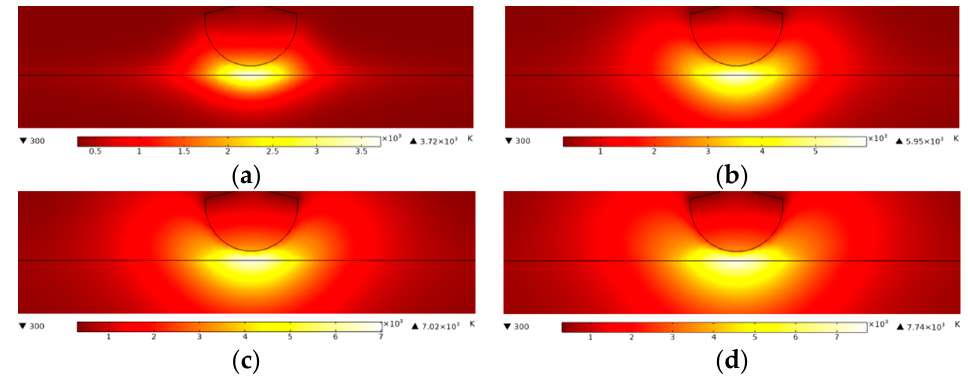
Figure 7. Temperature distribution cloud diagram of the pantograph–catenary arc (when gap is 3 mm). ( a ) 0.1 s cloud chart of arc temperature distribution; ( b ) 0.4 s cloud chart of arc temperature distribution; ( c ) 0.7 s cloud chart of arc temperature distribution; ( d ) 1 s cloud chart of arc temperature distribution. When the gap of the pantograph–catenary is 3 mm, two-dimensional trans sects are defined in the simulation software, which is defined as the upper half-axis of the arc central axis. The temperature curves of 10 durations within 0~1 s are extracted by the simulation software, as shown in Figure 8.